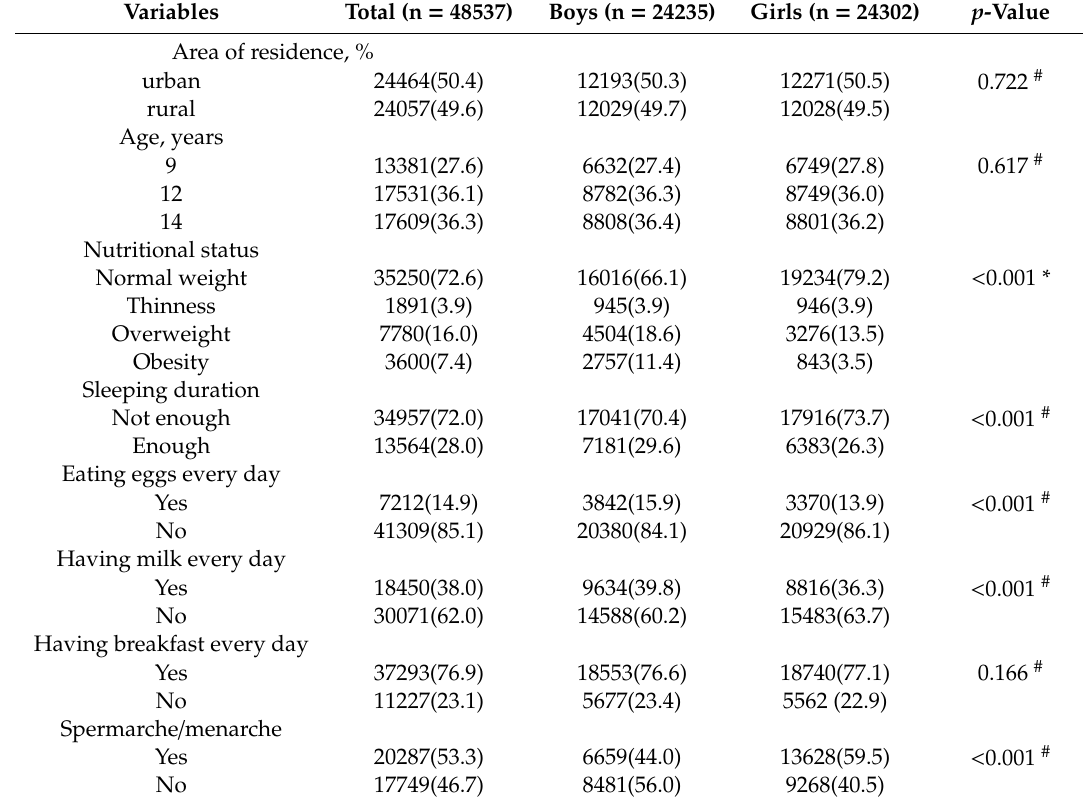
Table 1. Descriptive characteristics of the population included in this